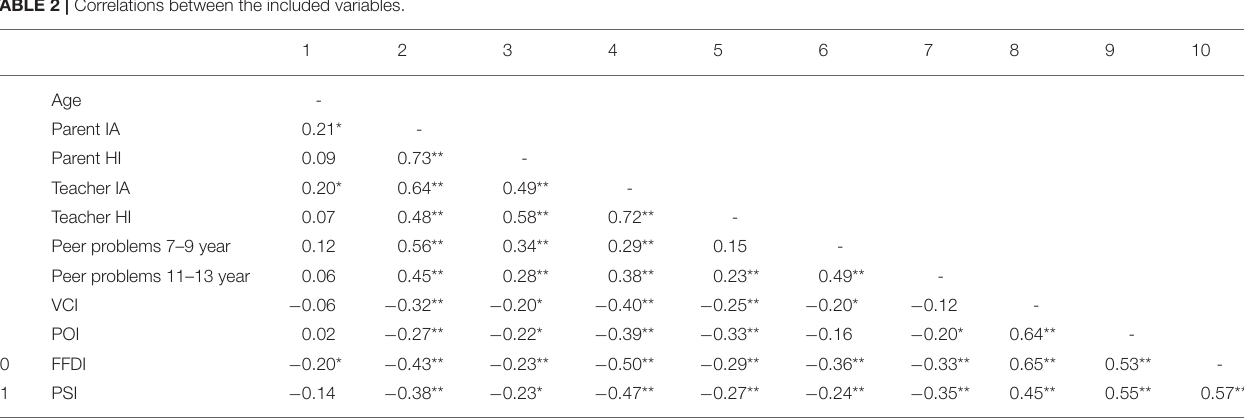
TABLE 2 | Correlations between the included